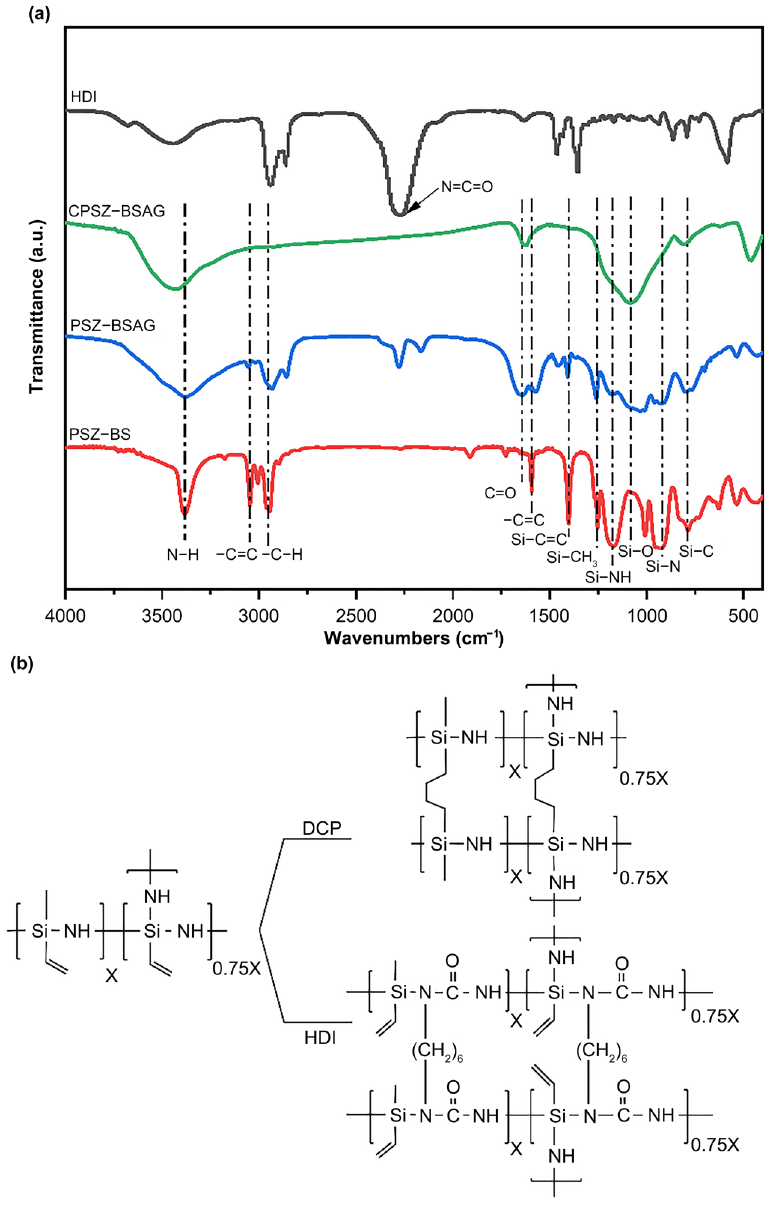
Figure 2. ( a ) FT − IR spectra of reactants (PSZ-BS and HDI), polymer-derived aerogel (PSZ-BSAG) and ceramic aerogel (CPSZ-BSAG). ( b ) Possible reactions during the process of sol–gel reaction. The changes in the surface area and pore size distribution of the PSZ-BSAGs materials synthesized with different solvent ratios during the sol–gel reactions were characterized by the nitrogen adsorption–desorption experiments (Brunauer–Emmett–Teller (BET) method). The adsorption–desorption isotherms of different samples are shown in Figure 3a. The results indicate that the PSZ-BSAGs are mesoporous materials according to the IUPAC classification. The hysteresis loops could be further classified as H3, where the isotherm does not terminate at high pressure, indicating a considerable fraction of large mesopores and macropores. The BET surface areas of the PSZ-BSAGs are 52.7, 56.8, and 67.5 m 2 g − 1 , respectively, which increase as the solvent ratio increases (85, 90, and 95 wt.%, respectively); the pore volumes are 0.17, 0.18, 0.19 cm 3 g − 1 , respectively (Table 1). Moreover, this trend indicates that the volume of the adsorbed gas increases with the solvent ratio, which can be attributed to the fact that more toluene solvent occupies more space during the